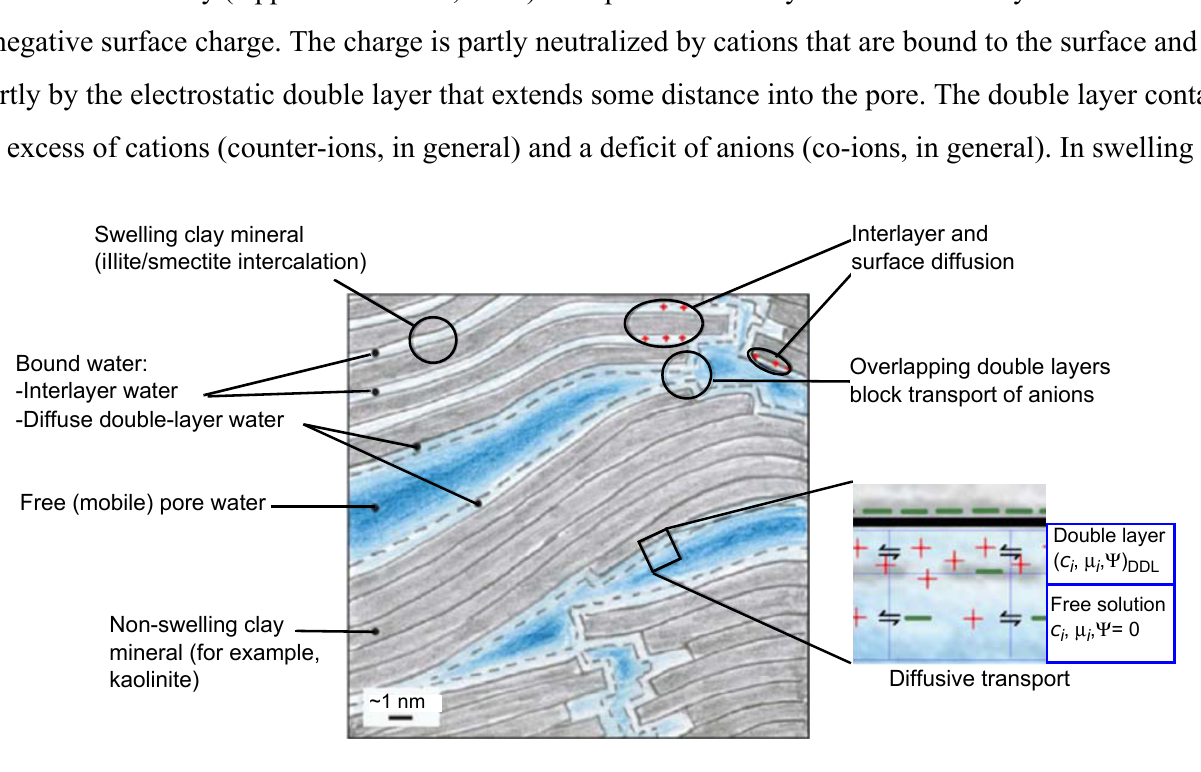
Figure 22. A diagram of the pore space in Opalinus Clay, showing three water types with associated diffusion domains. The right-hand side presents a pore as simplified in PHREEQC (Modified from Nagra, 2002; Appelo and others,